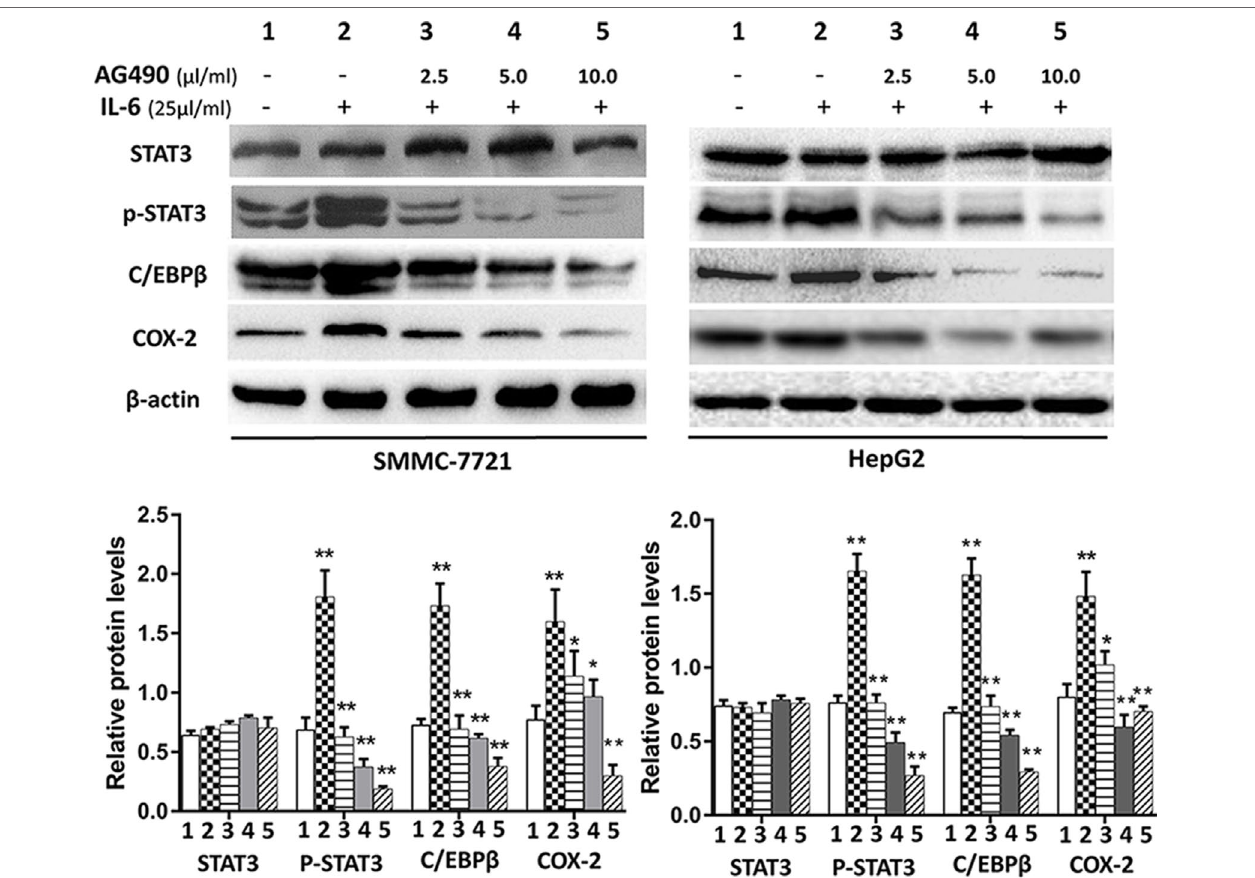
FIGURE 5 | Protein expression of total STAT3, p-tyr-705 STAT3, C/EBP β and COX-2 following treatment with AG490 (JAK2 inhibitor). Cell culture conditions are as described in Figure 4 . Tumor cells (HepG2 and SMMC-7721) were divided into different groups and treated with different concentrations of AG490 as follows: 1) control group: cells received no drug treatment; 2) cells treated with IL-6 (25 ng/ml) only; 3) cells treated with IL-6 (25 ng/ml) + AG490 (10 μmol/L); 4) cells treated with IL-6 (25 ng/ml) + AG490 (50 μmol/L); 5) cells treated with IL-6 (25 ng/ml) + AG490 (100